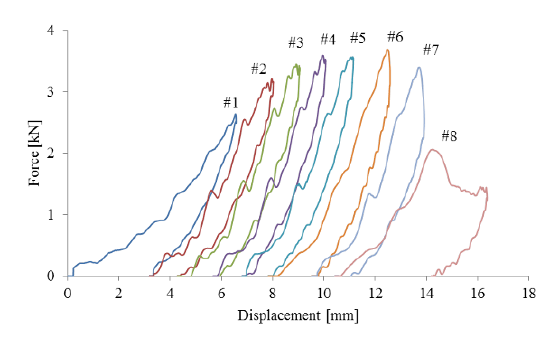
Figure 11. Deflection recovery vs. number of impacts. Figure 12. Force-displacement curves with displacement off-set ap-